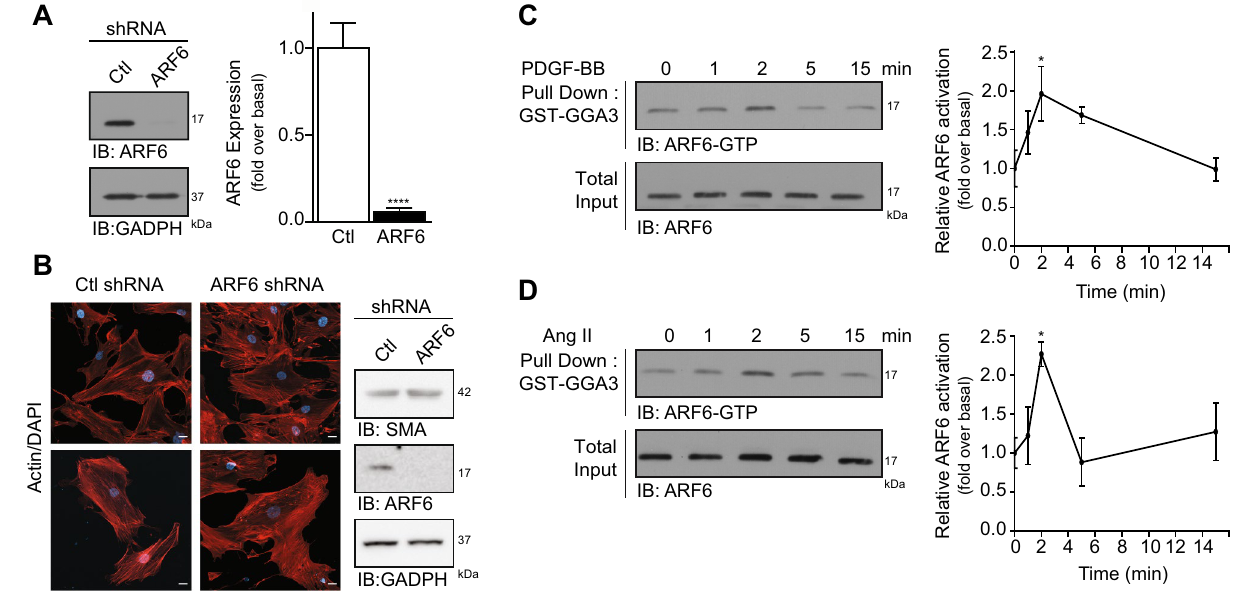
Figure 1. ARF6 is activated in HASMC through RTK or GPCR signaling pathway. ( A ) Cells were infected with a Ctl or ARF6 shRNA. After 72 h, cells were lysed and ARF6 expression was assessed by Western blotting using specific antibodies. Quantifications are the mean ± SEM realised on eight different experiments. **** P < 0.0001 (Student’s t -test). ( B ) Cells were infected as in ( A ) and after 72 h, cells were fixed and actin stained using Alexa Fluor 568 phalloidin or cells were lysed and SMA expression was assessed by Western blotting using specific antibodies (Bar = 20 µm), n = 5. ( C , D ) Cells were serum starved 16 h before stimulation with 25 ng/mL of PDGF-BB ( C ) or 100 nM of Ang II ( D ). They were stimulated for 0, 1, 2, 5 and 15 min. Cells were lysed and ARF6 activity was assessed in a GTPase activation assay with GST-GGA3. ARF6-GTP levels were evaluated by Western blotting using specific antibodies against ARF6. Quantifications are the mean ± SEM realised on four ( C ) or three ( D ) different experiments. *P < 0.05. (One-Way